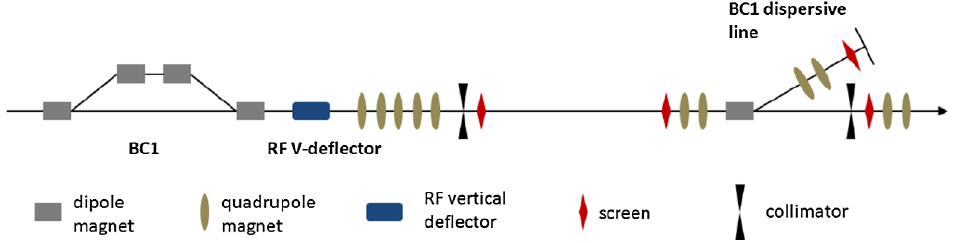
FIG. 2. Layout of the Fermi@Elettra BC1 area (conceptual, not to scale). The last quadrupole magnet of the group of 5 downstream of BC1 is used for the beam size scan and emittance measurement.